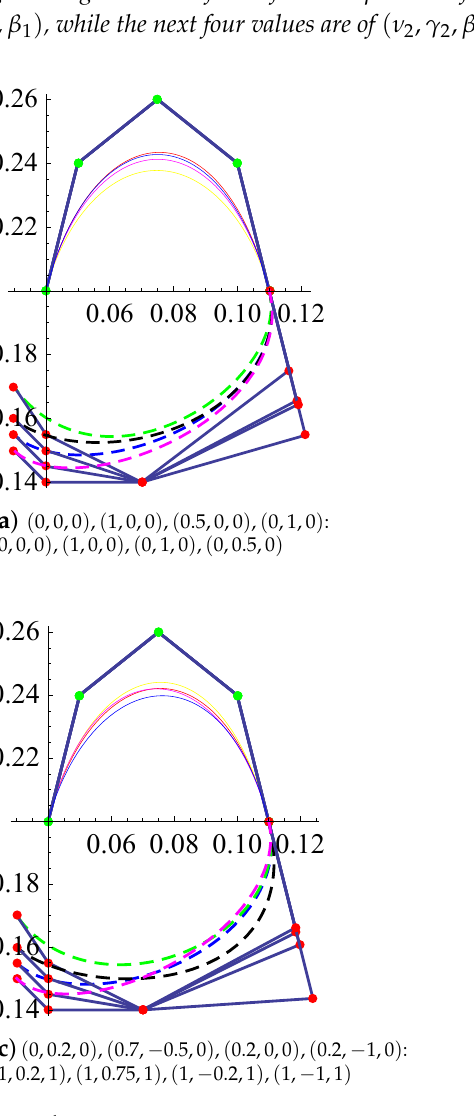
0.5,0 ) , ( 0.2,0,0 ) , ( 0.2, 1,0 ) : ( 1,0.2,1 ) , − − 0.5,0 ) : ( 0, 0.5,0 ) , ( 1,1,0 ) , − −